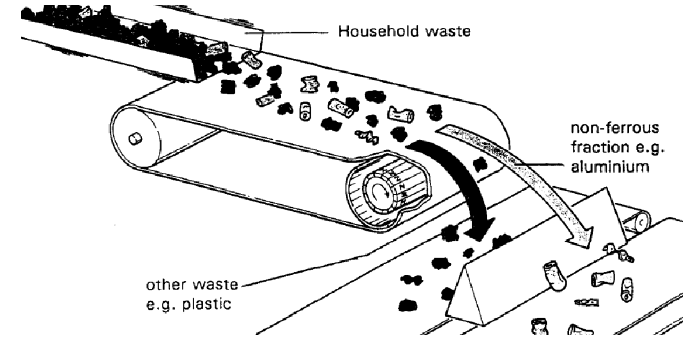
Figure 8. Conveyor-type eddy-current separator. Reproduced with permission from [40], Elsevier,